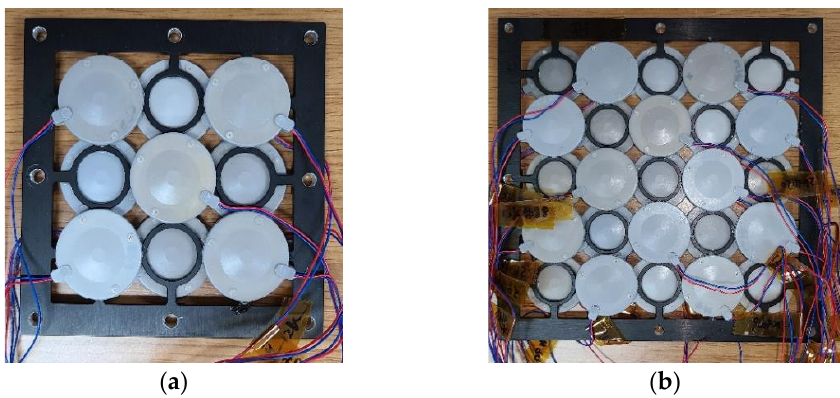
Figure 19. Prototypes of the two-layered cymbal arrays: ( a ) 3 × 3 array; ( b ) 5 × 5 array.